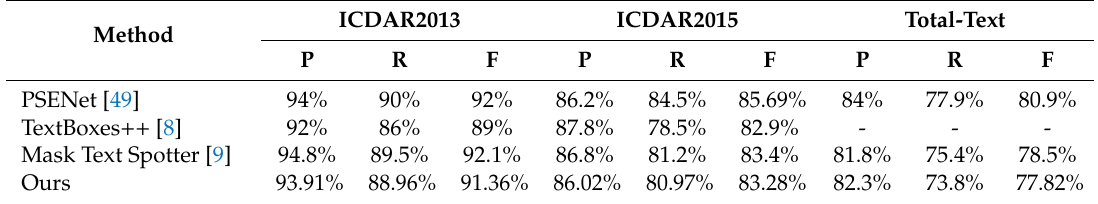
Table 4. Scene text detection result of the proposed method compared with previous